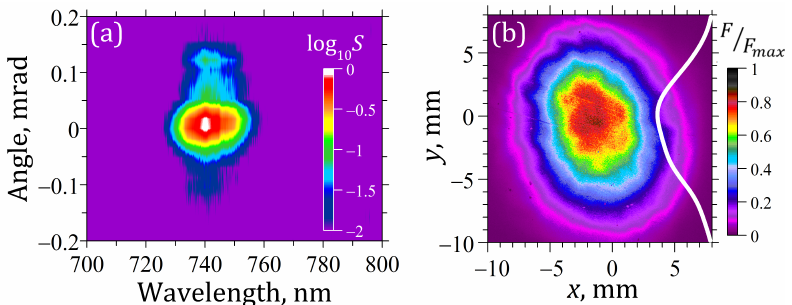
Figure 1. Experimentally measured initial ( a ) angle-wavelength spectrum and ( b ) transverse fluence distribution with its slice at x = 0 (white curve) at z = 13 m from the compressor